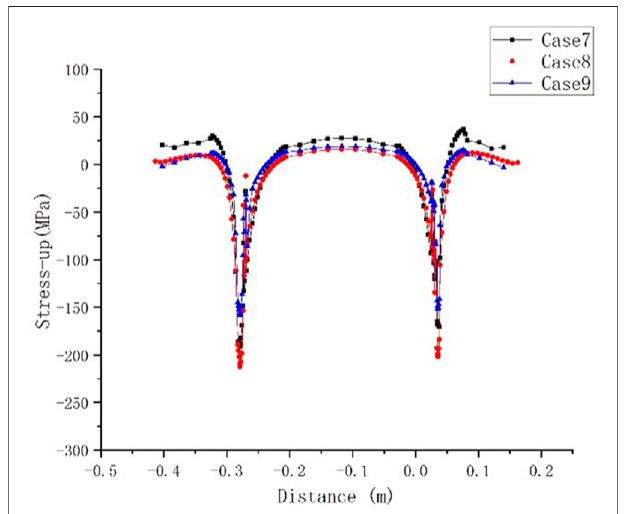
FIGURE 9 | Residual stress σ x along the x -direction (t1 = 10 mm). FIGURE 10 | Residual stress